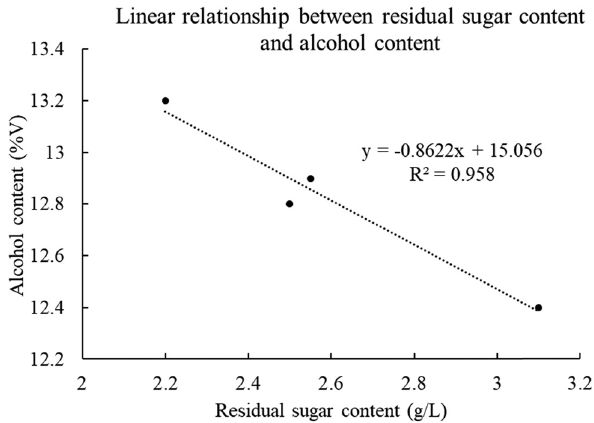
Figure 1: Linear relationship between residual sugar content ( g/L ) and alcohol content ( % vol )